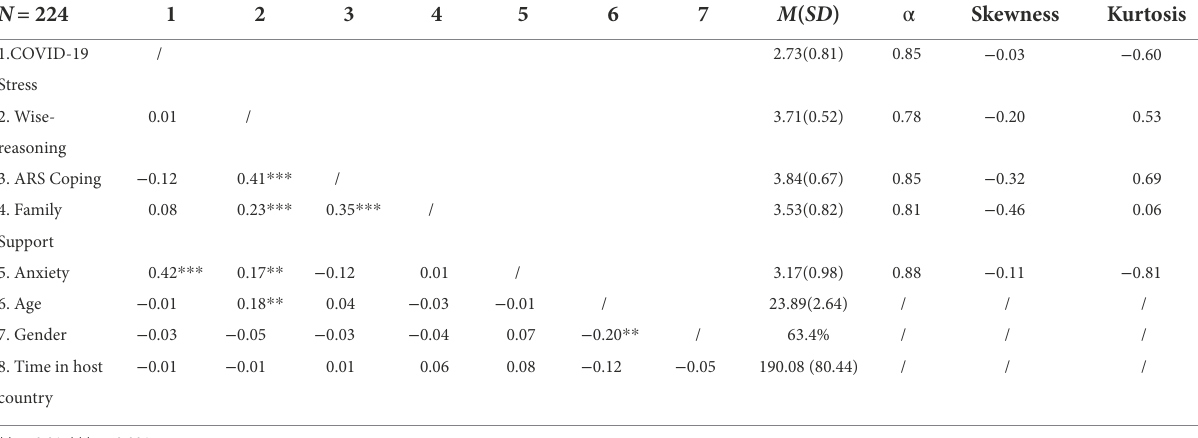
TABLE 1 Bivariate correlations of core variables.